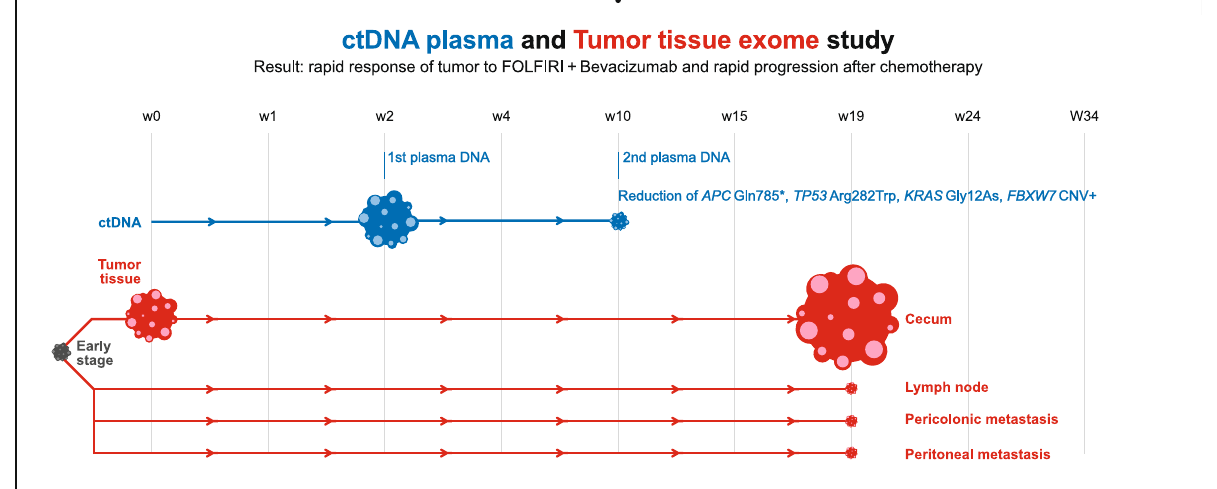
Fig. 1 Blood plasma ctDNA and tumour tissue sequencing reveals rapid response to FOLFIRI+Bevacizumab and rapid progression after